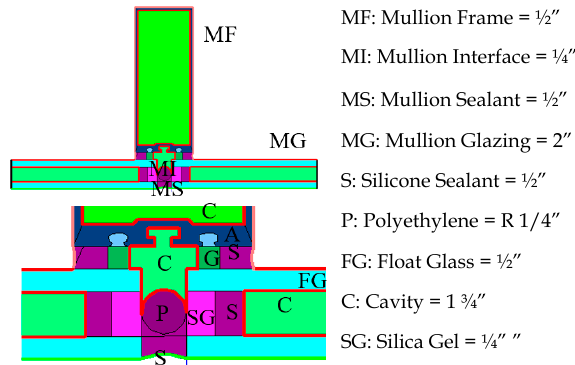
Figure 3. Parts of the mullion and the shadow box of the curtain wall.